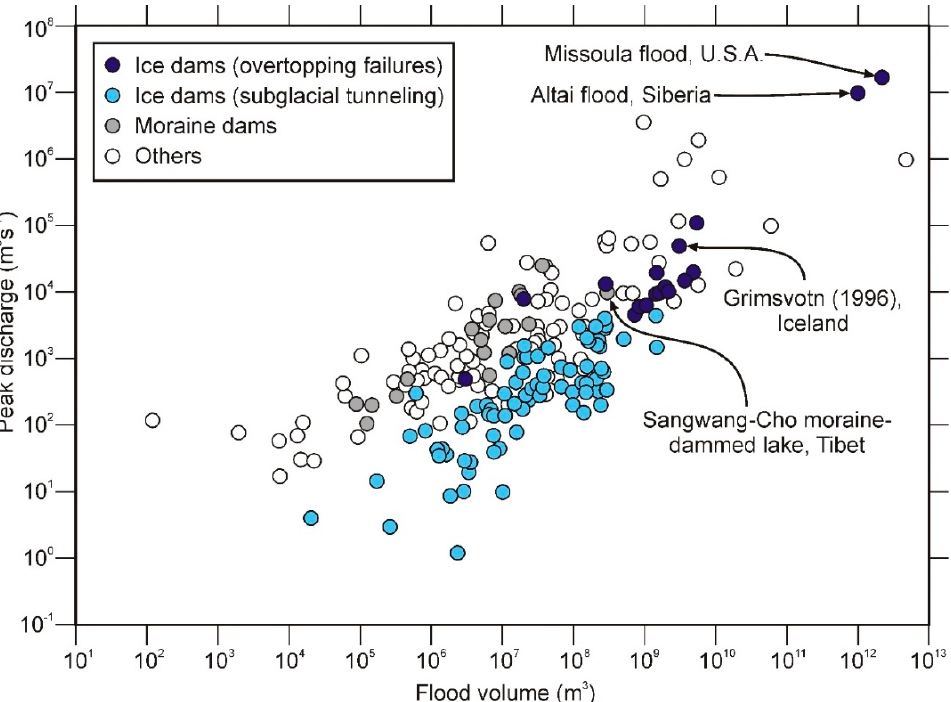
Figure 7. Outburst floods for which flood volume and peak discharge are known. The largest floods of each type are labeled. (From [28], Figure 14.1).